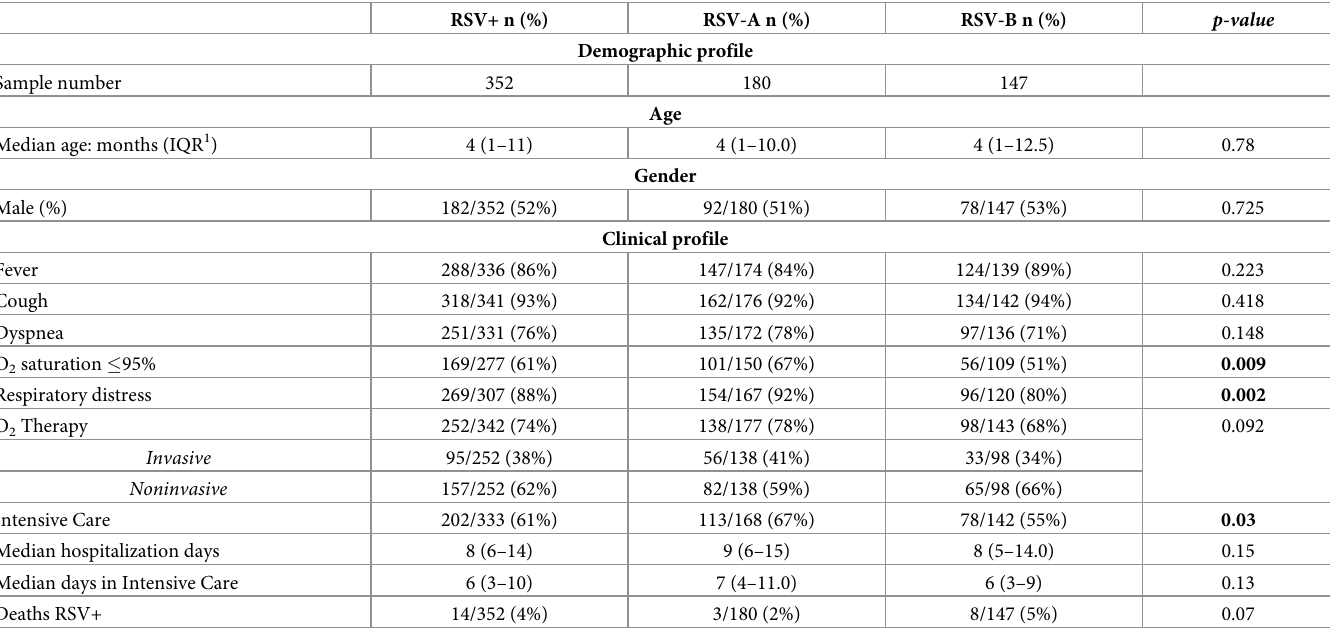
Table 2. Summary of clinical and epidemiological data by RSV+ and each